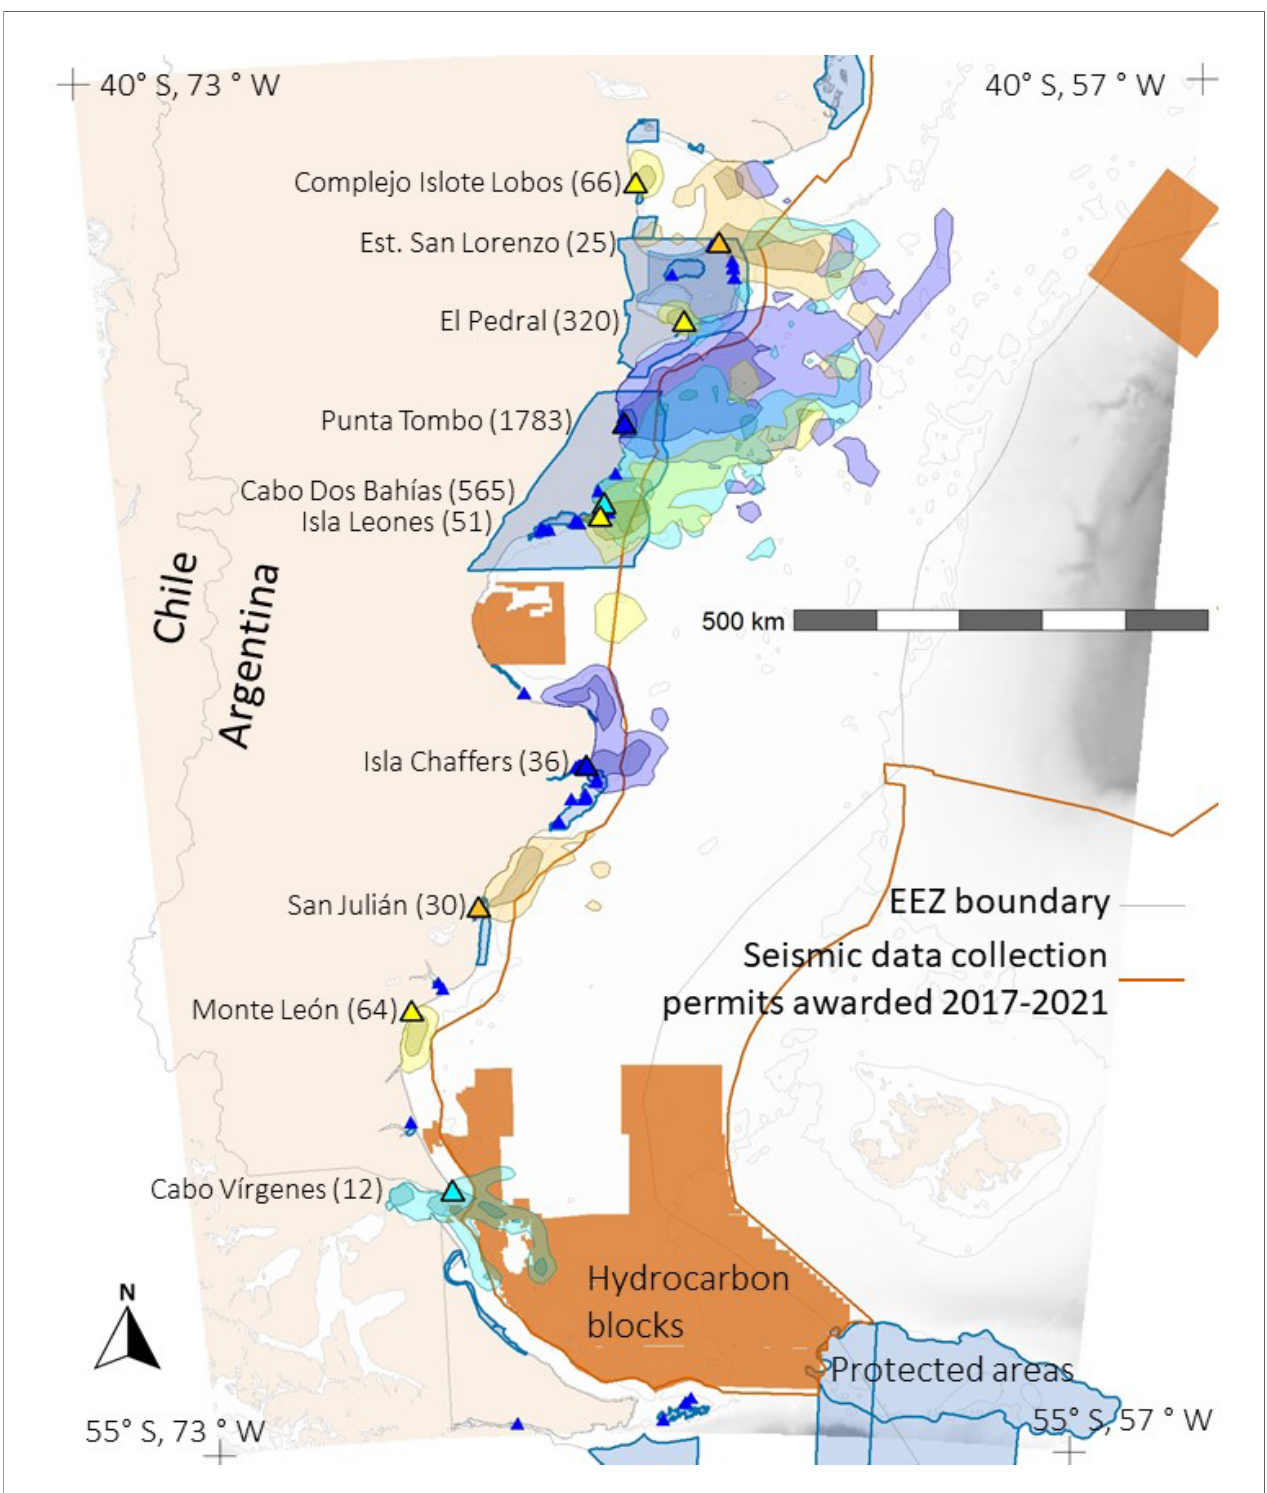
FIGURE 1 | Foraging areas (colored polygons) of Magellanic penguins breeding at 10 colonies in Argentina. Dark colors represent 50% UD kernel contours, light colors 90% UD kernel contours. Blue areas show marine protected areas and orange areas show hydrocarbon concessions. Large triangles mark colonies with tracking data; color matches color of foraging area polygons. Number of foraging trips are in parentheses following colony names. Small dark blue triangles mark penguin colonies where we did not have tracking data. The tan color is land. Shades of gray indicate ocean depth, with white indicating the continental shelf (< 120 m). The thin gray line marks boundaries of Argentina ’ s exclusive economic zone (EEZ). The orange line encloses the area where Argentina awarded seismic-data collection permits in